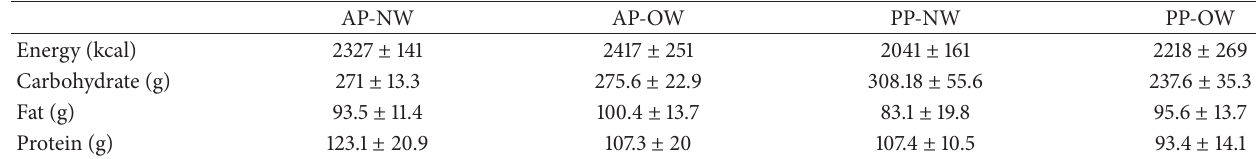
Table 3: Energy and macronutrient content of 24-hour food